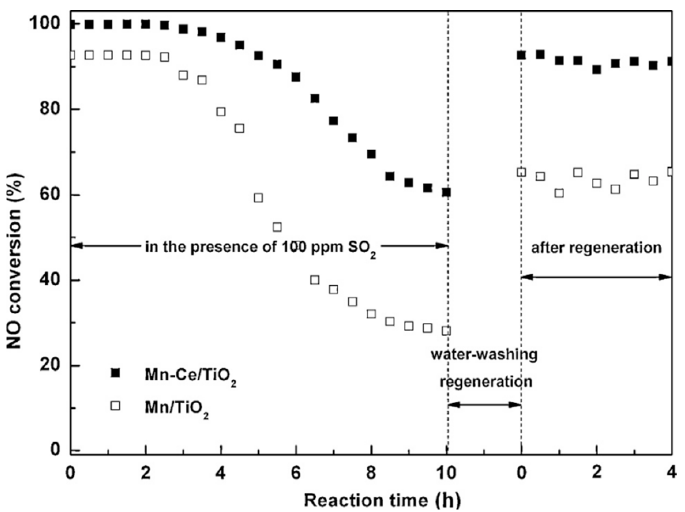
Figure 28. SCR activities of Mn/TiO 2 and Mn-Ce/TiO 2 in the presence of SO 2 at 150 °C. ([NH 3 ] = [NO] = 800 ppm, [O 2 ] = 3%, [SO 2 ] = 100 ppm, [H 2 O] = 3 vol%, N 2 balance, GHSV = 40,000 h − 1 ) [18].